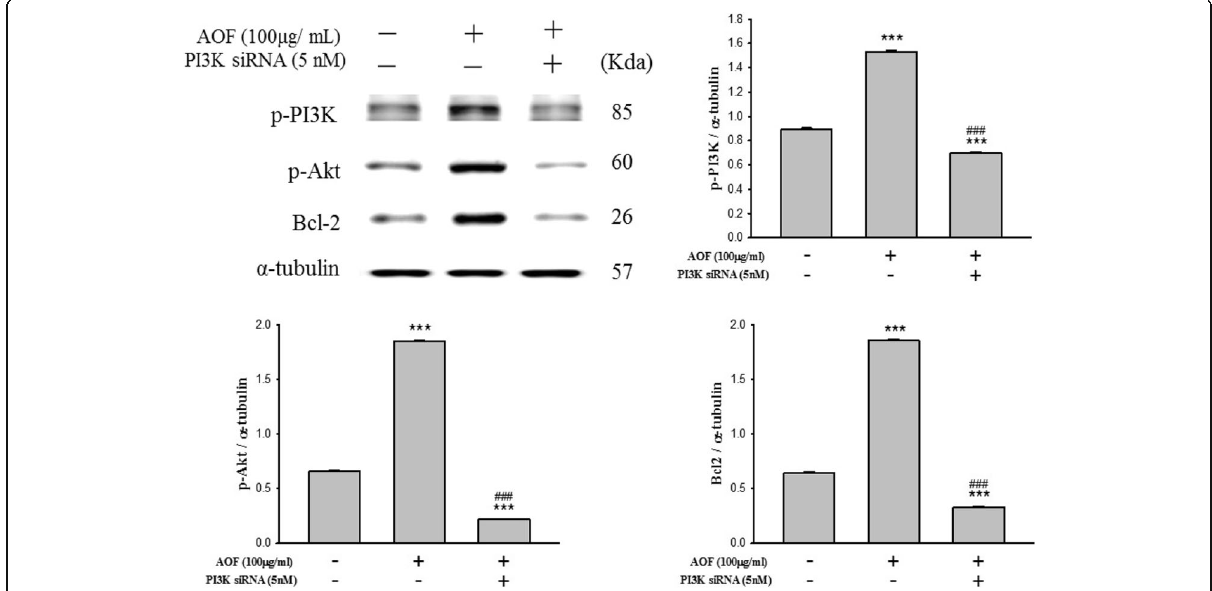
Fig. 6 PI3K knockdown inhibited AOF extract-induced survival and proliferation. Schwann cell was transiently transfected with 5 nM PI3K siRNA for 1 h prior to treatment. After incubation with 100 μ g/mL AOF extract for 24 h, cells were harvested and analyzed by immunoblotting. α -tubulin was used as a loading